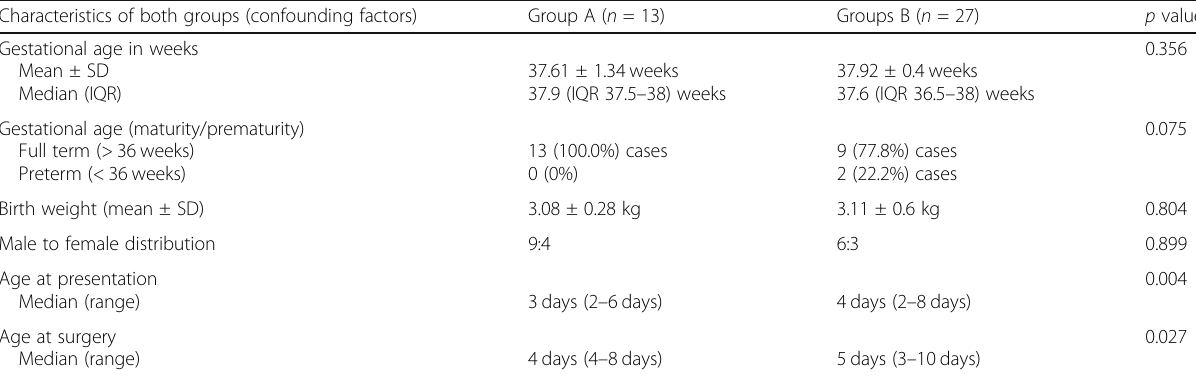
Table 1 Characteristics of both groups Characteristics of both groups (confounding factors) Group A ( n = 13)